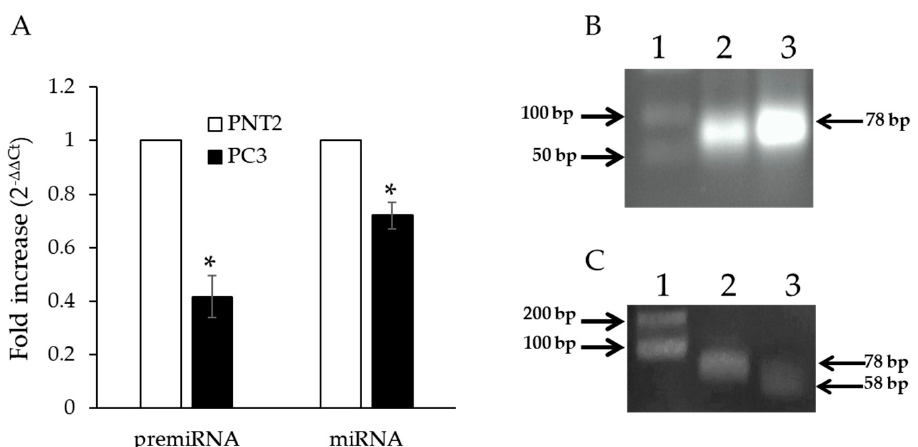
Figure 1. Endogenous miRNAs Let-7b in PC3 and PNT2 cell lines. ( A ) qPCR of pre-miRNA Let-7b and mature miRNA Let-7b in PC3 and PNT2 cells. Gene expression values were normalized to U6 snRNA and presented as 2 − ∆∆ Ct . Relative RNA abundance in PNT2 cells was assumed as 1. Data represent mean ± SD ( n = 5). * p < 0.05. ( B ) Semiquantitative PCR pre-miRNA Let-7b in PC3 (lane 2) and PNT2 cells (lane 3). ( C ) PCR pre-miRNA Let-7b (lane 2) and heminested pre-miRNA Let-7b (lane 3) in PC3 cells.